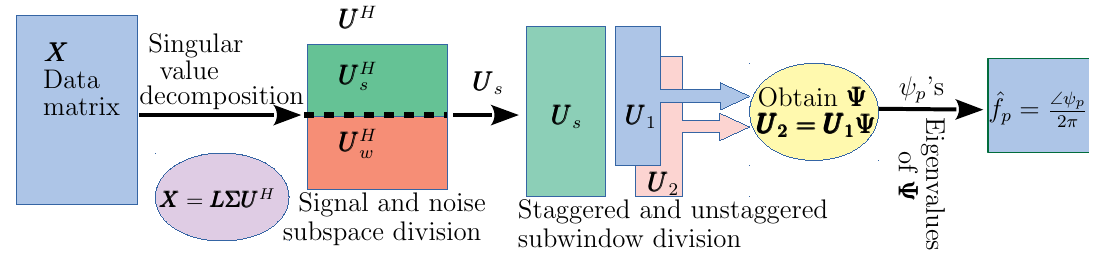
Figure 2. Demonstrating the block diagram of the ESPRIT